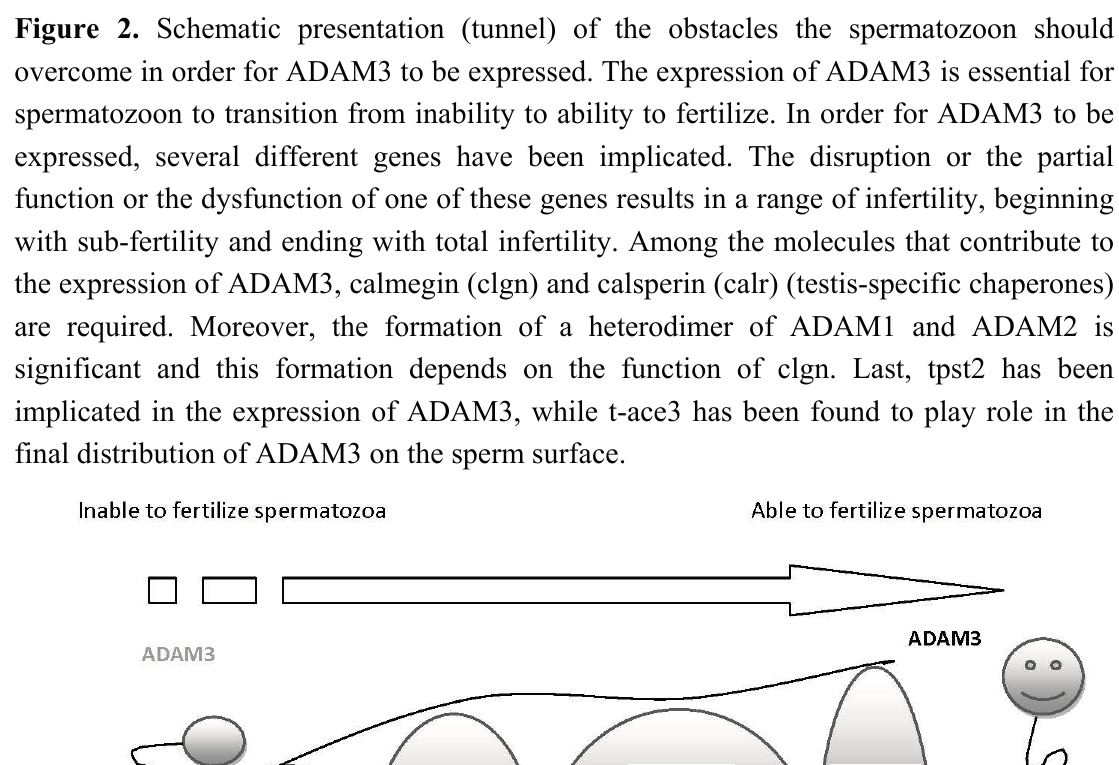
Figure 2. Schematic presentation (tunnel) of the obstacles the spermatozoon